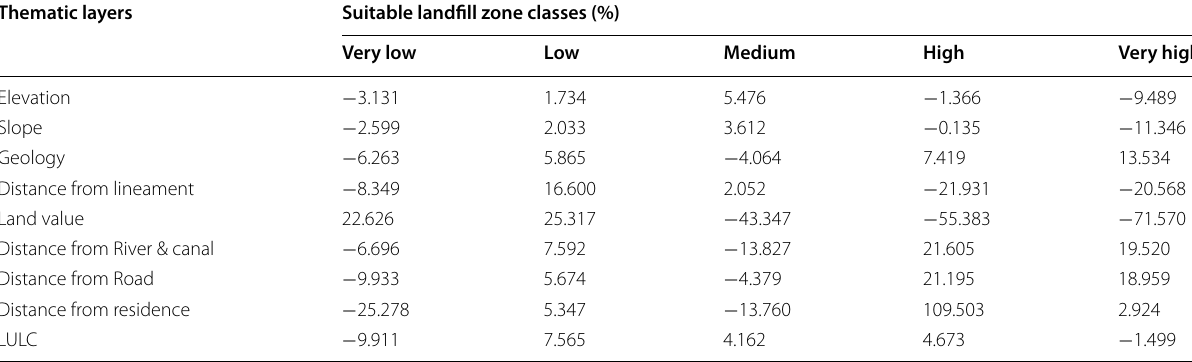
Table 10 Percentage of changes of suitable land filling zone with map removal sensitivity